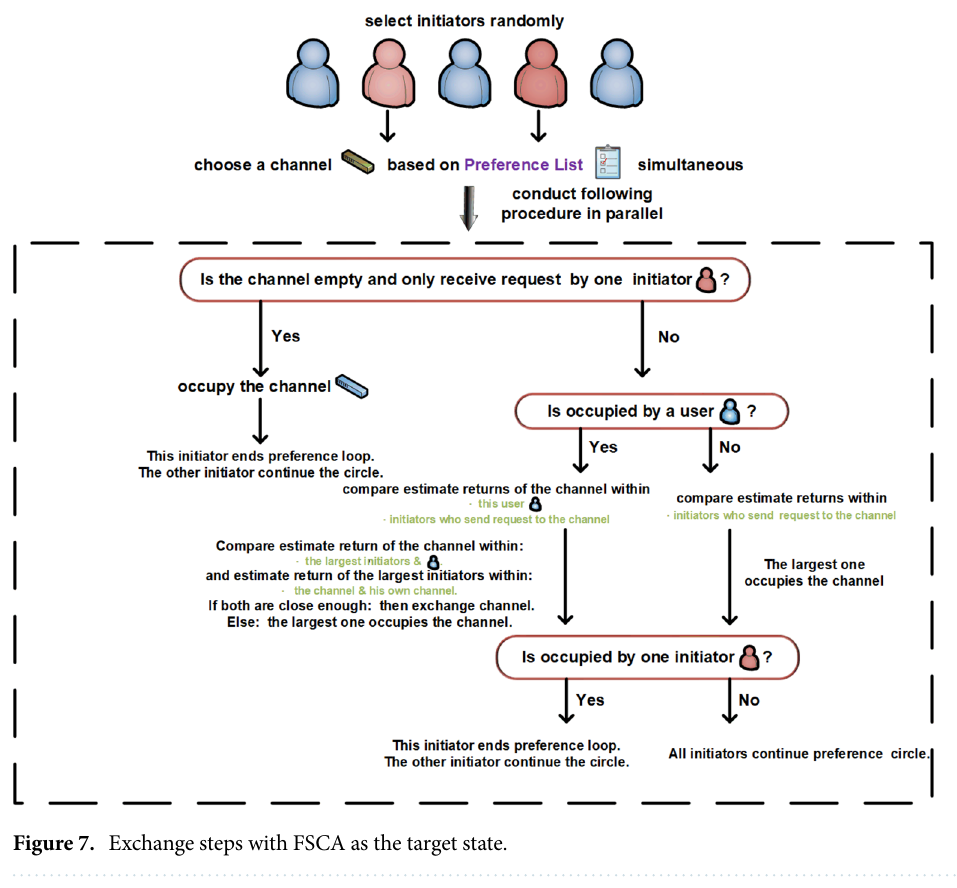
Figure 7. Exchange steps with FSCA as the target state.